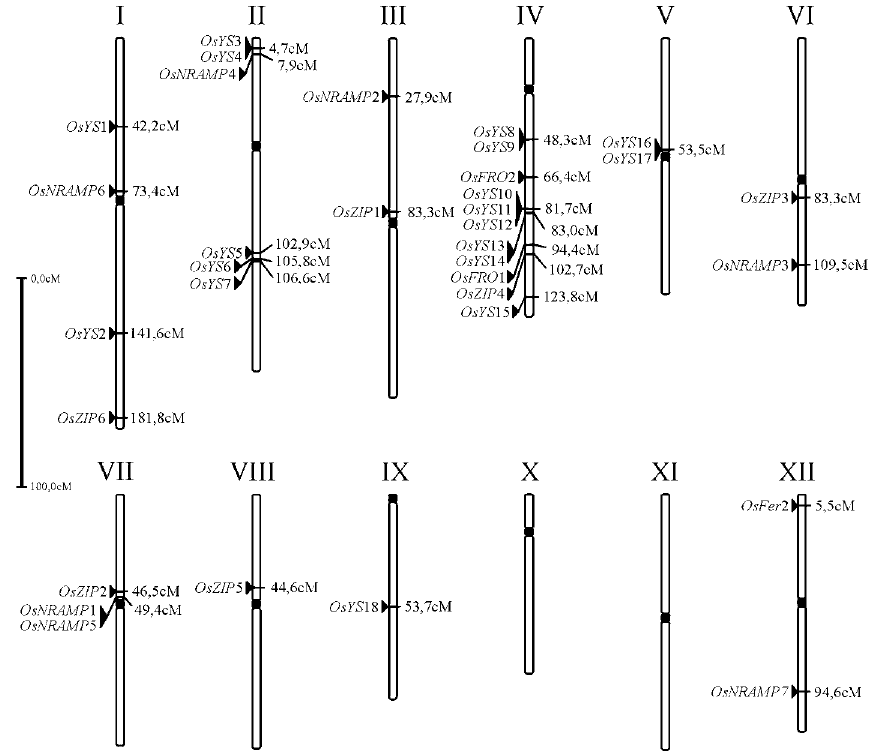
Figure 1 - Chromosome locations of the putative genes related to the iron homeostasis families in rice. All positions in centMorgans (cM) were estimated in accordance to genetic markers assigned to the BAC/PAC clones (as shown by the TIGR genetic map browser: http://www.tigr.org/tdb/e2k1/osa1/ BACmapping/description.shtml) related to the predicted sequences. Roman numbers indicate each of the twelve rice chromosomes depicted in white with cetromeres shown in black. The proposed gene nomenclature is as follows: OsYS , Oryza sativa Yellow Stripe-like ; OsFRO, Oryza sativa Fer- ric-chelate reductase-like ; OsZIP, Oryza sativa Zip-like ; OsNRAMP , Oryza sativa Nramp-like ; OsFer , Oryza sativa Ferritin-like . It was not possible to assign a position for five putative genes ( OsIRT1 , OsIRT2 , OsZIP9 , OsZIP10 , OsZIP11 ), since these genes were predicted from the BGI scaffolds not an- chored to any rice chromosome